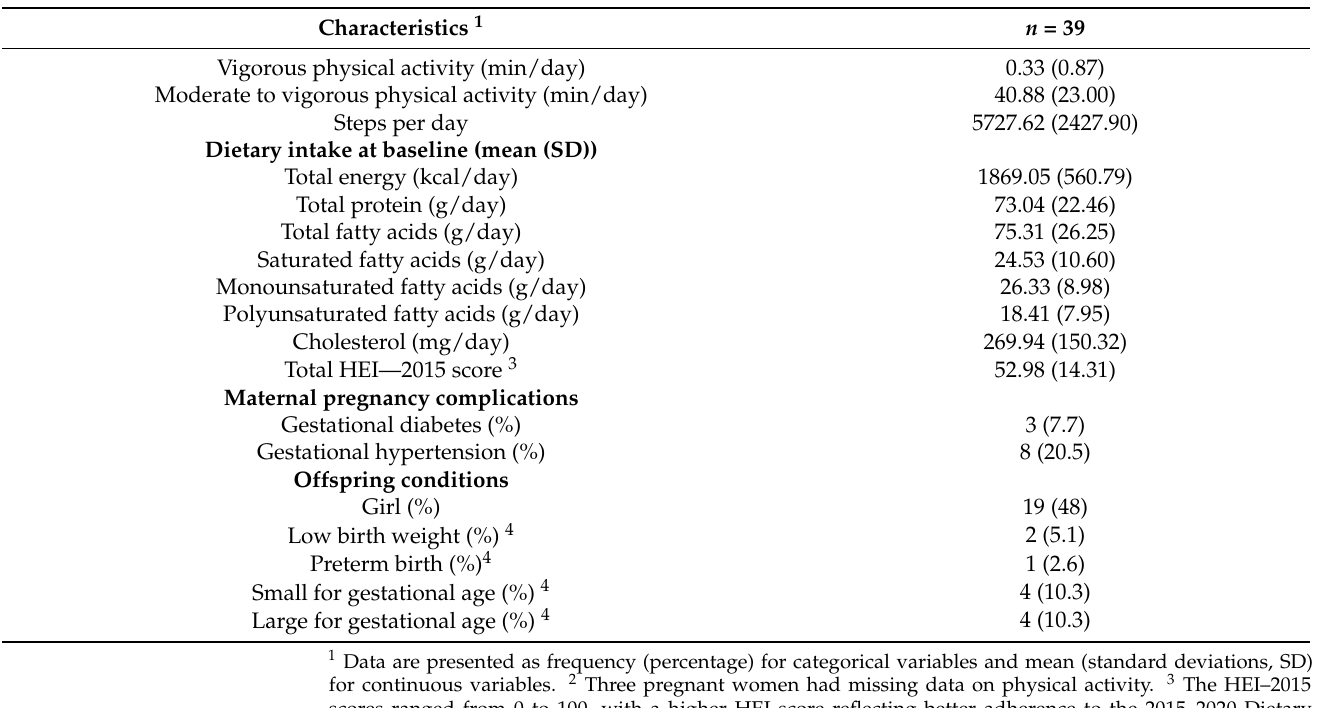
Table 1. Cont. Characteristics 1